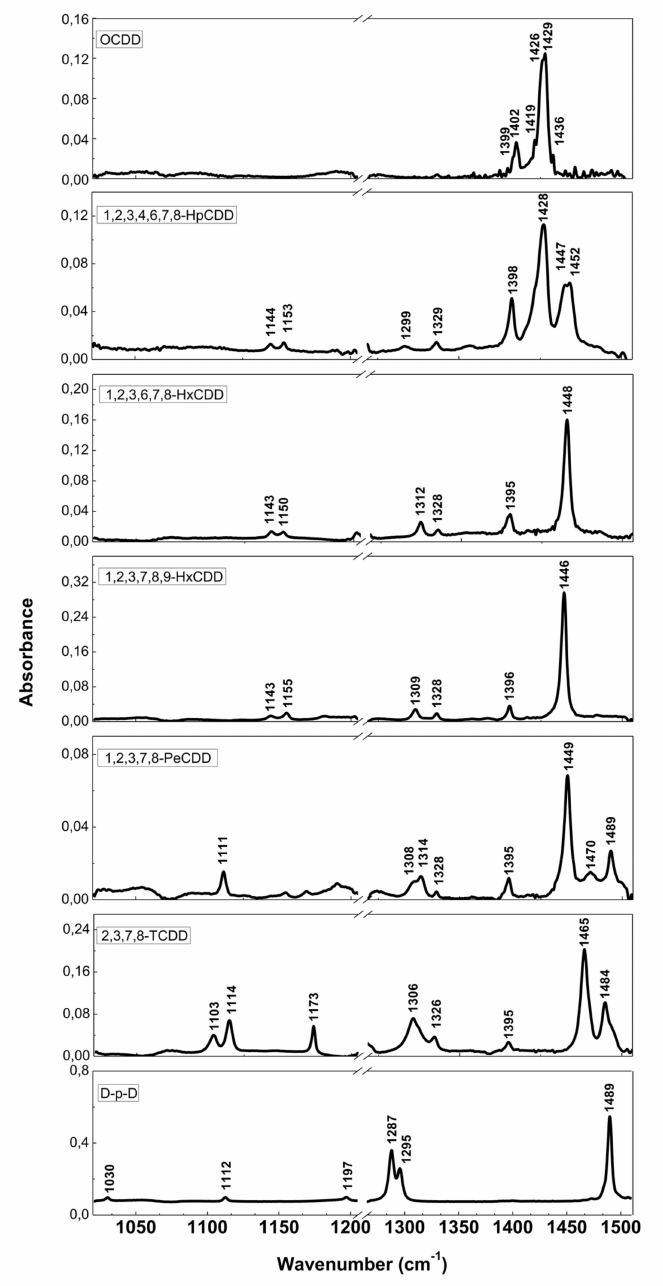
Figure 3. FT-IR spectra of PCDDs and dibenzo-p-dioxin (D-p-D). Reprinted with permission from [19], copyright